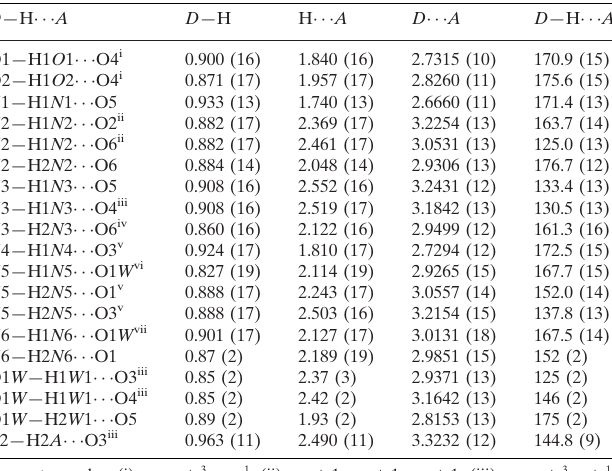
Hydrogen-bond geometry (A˚ , (cid:4)